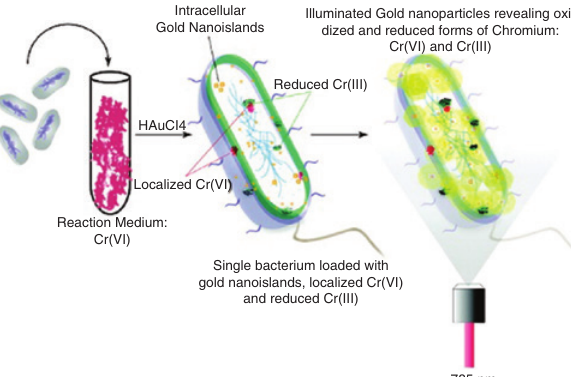
Figure 2: Single cell Raman chemical imaging driven by intracellu- larly grown gold nanoislands to obtain detailed chemical localiza- tion and oxidation state information for Cr(VI) and Cr(III) in living cells. Reproduced from Ravindranath et al. ACS Nano 2011 , 5